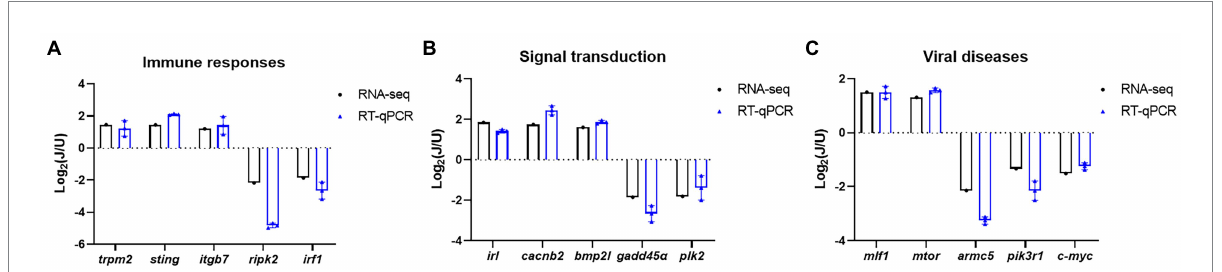
FIGURE 6 Validation of selected DEGs related to immune responses, cellular signal transduction, and viral diseases. (A) DEG expression levels for genes related to immune responses. (B) DEG expression levels for genes related to cellular signal transduction. (C) DEG expression levels for genes related to viral